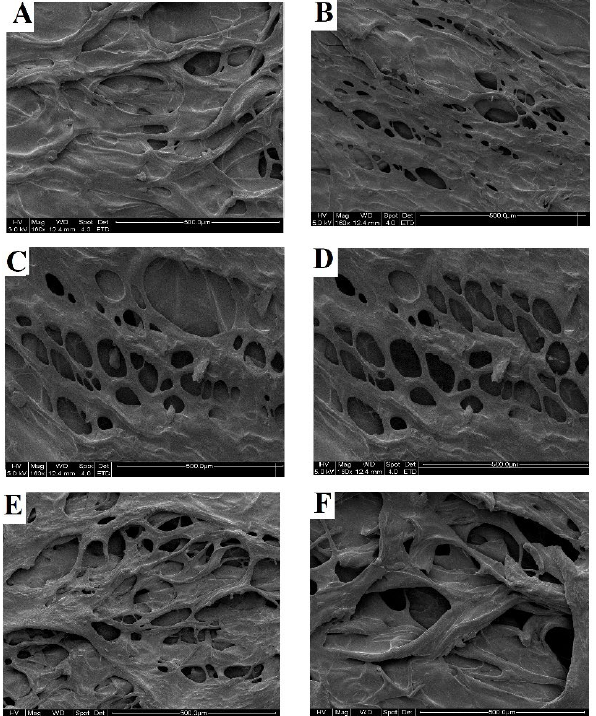
Figure 5. SEM of immobilized enzymes produced with UMS treatment generated at the different MS powers ( A ) 0 W, ( B ) 20 W, ( C ) 40 W, ( D ) 60 W, ( E ) 80 W, ( F ) and 100 W, at 160× magnification.